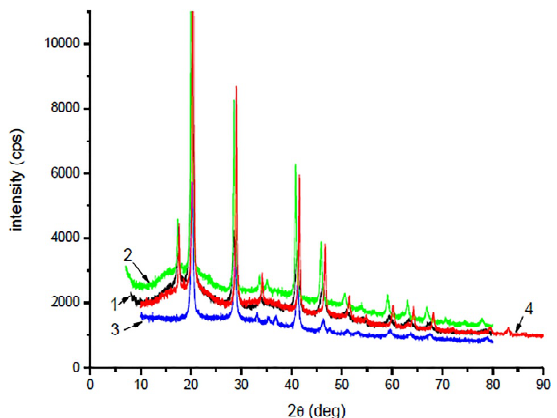
Fig. 3. Types of diffraction patterns of 1 - nickel HCF, 2 - cobalt HCF, 3 - iron HCF and 4 - copper